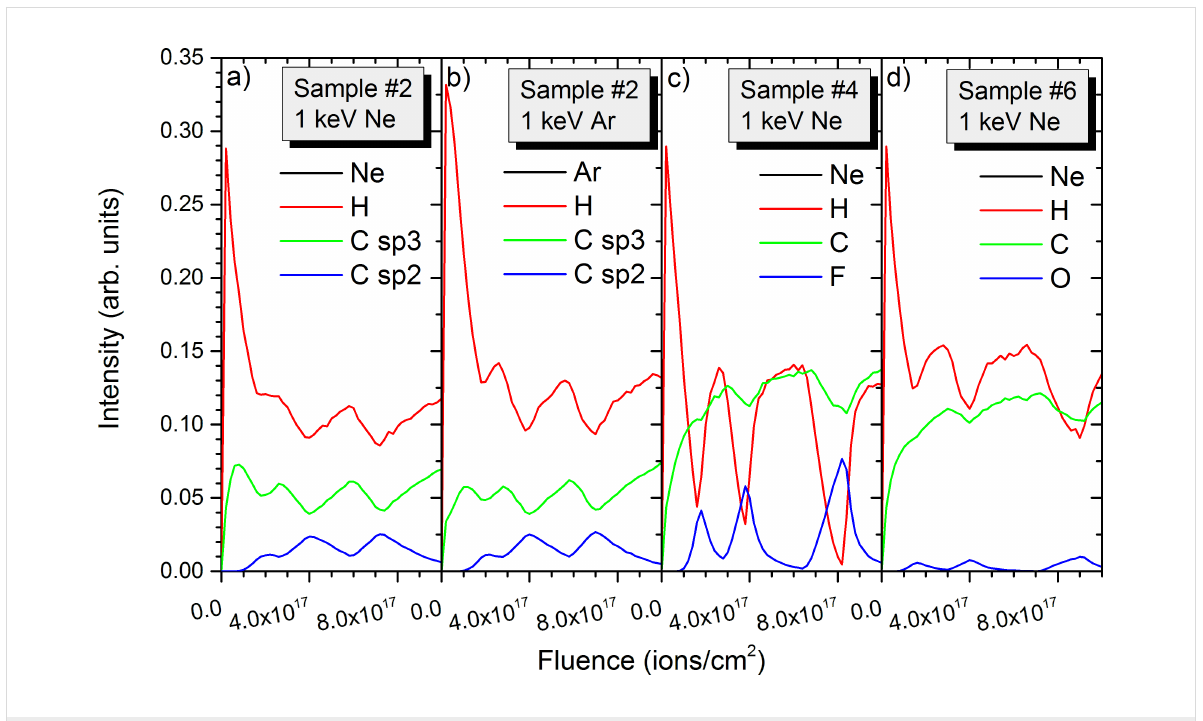
Figure 10: Simulated depth profiles for a) 1 keV Ne + irradiation of sample #2, b) 1 keV Ar + irradiation of sample #2, c) 1 keV Ne + irradiation of sam- ple #4, and d) 1 keV Ne + irradiation of sample #6. Sample #2 has an inter-layer spacing of 10 nm and 20 nm, and samples #4 and #6 have an inter- layer spacing of 20 nm and 40